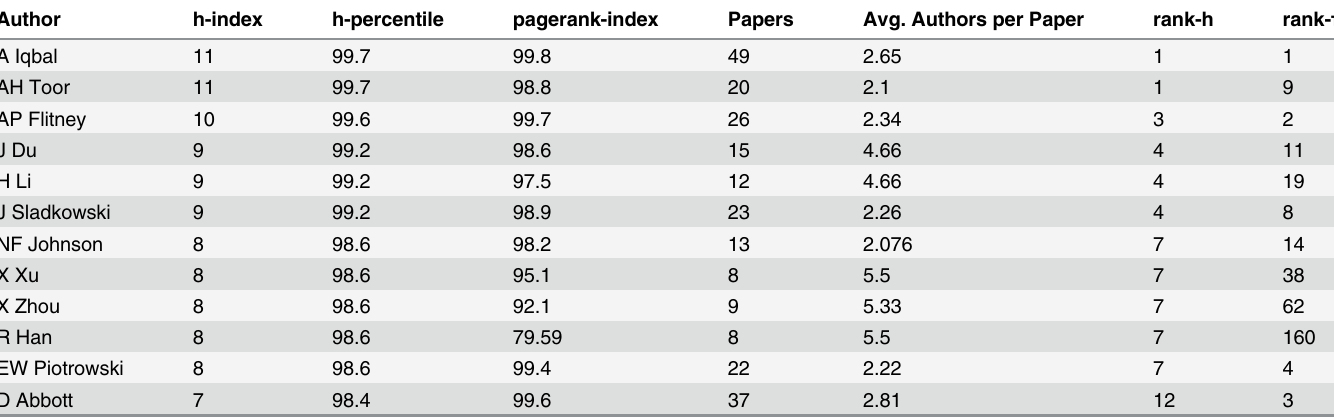
Table 1. The top 12 scientists as ordered by their h-index in the field of quantum game